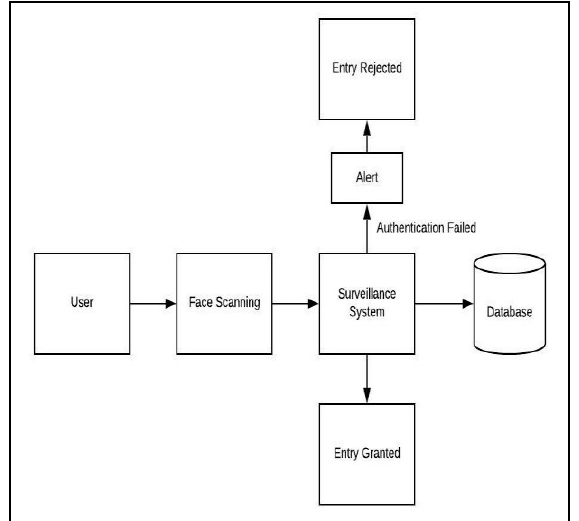
Fig. 1. Proposed System Design